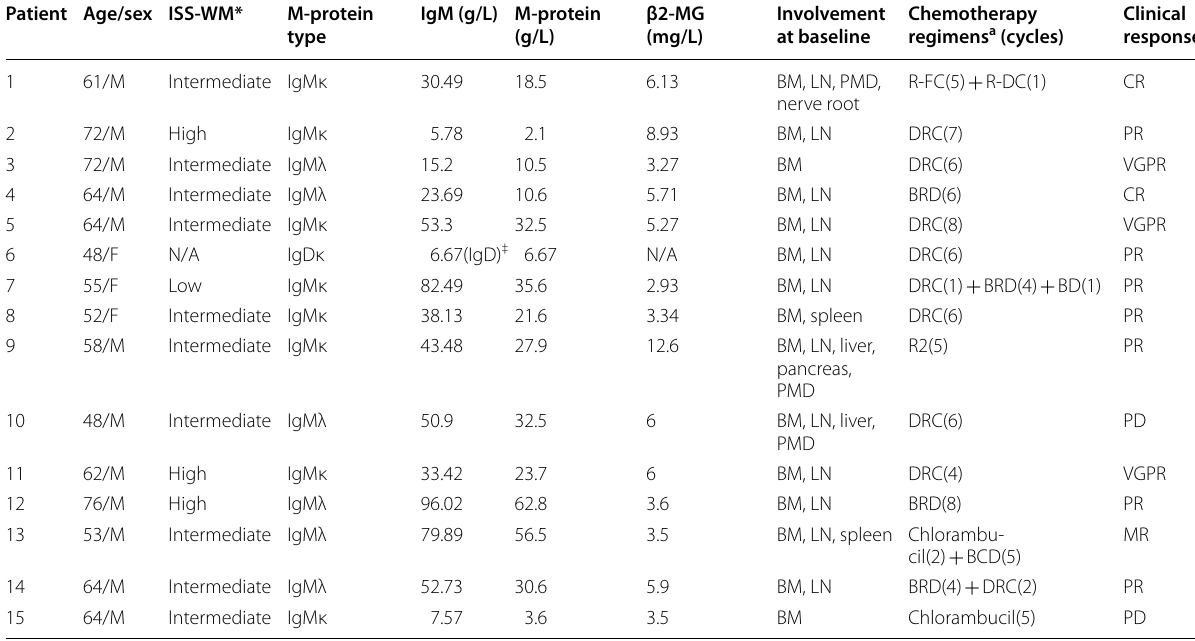
Table 1 Patients’ clinical characteristics and treatment